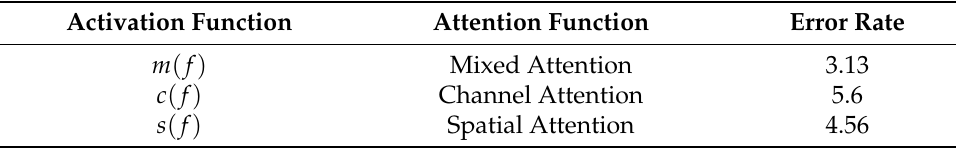
Table 1. Experimental results on CASME2 micro expressions dataset implemented on proposed Lossless Attention Residual Network (LARNet) consisting of Attention ResNet-92, Attention ResNet- 56 and custom build Attention ResNetEmotion